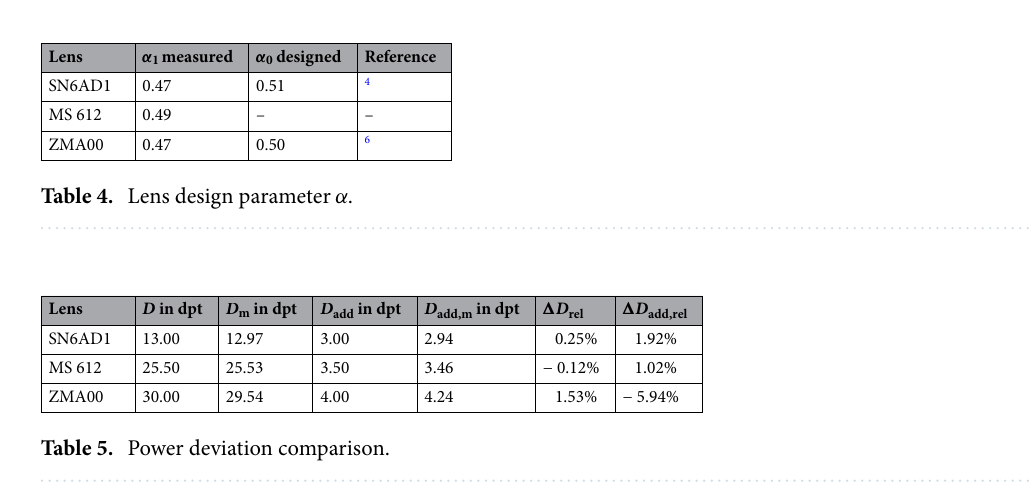
Figure 6. Comparison of measured (dots) and model (line) zone edge positions.